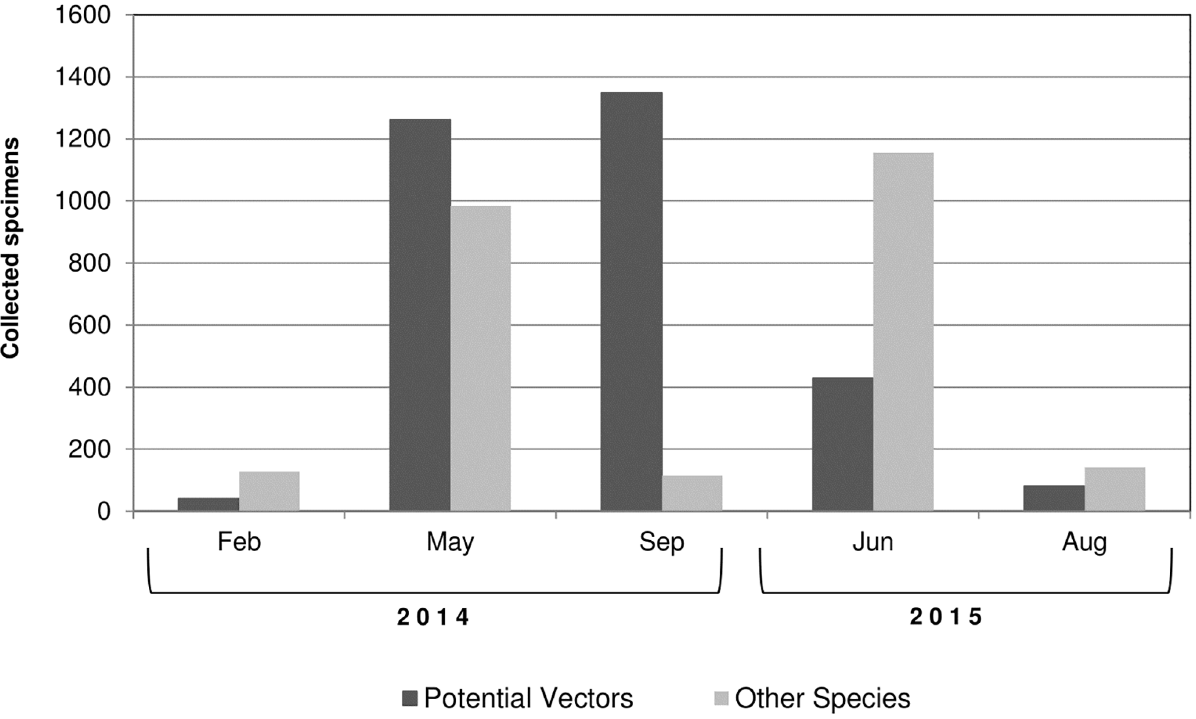
Fig 3. Relative abundance of sand fly specimens. This figure shows changesin sand fly abundance of putative vectors and non-vectors by month of collection.